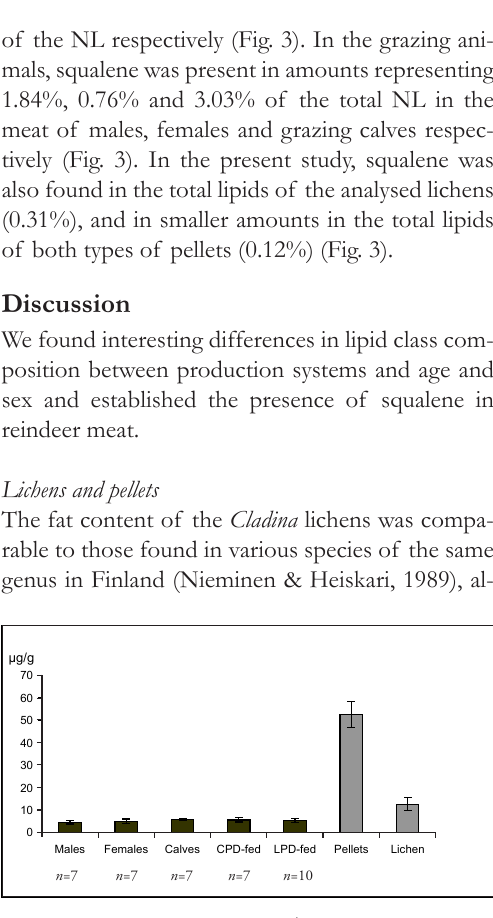
Fig. 4. α -tocopherol content (µg/g) in meat ( M. longissi- mus thoracis ) from reindeer fed different types of pellets compared to free ranging animals of differ - ent age and sex and in pellets and lichen (modified from (Sampels , 2005)) (mean values and standard deviation). Abbreviations: CPD: conventional pel- let diet; LPD: linseed pellet